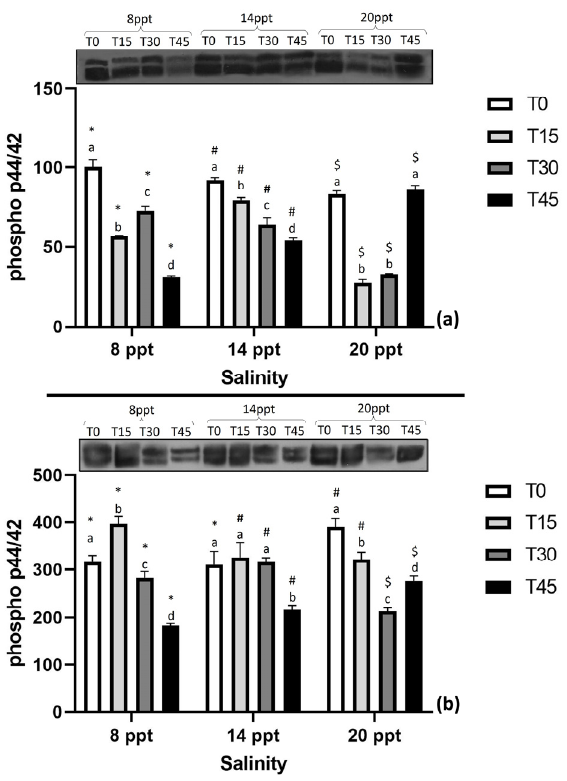
Figure 3. Phosphorylation levels of p44/42 MAPK in the liver ( a ) and gills ( b ) of gilthead sea bream following exposure to a salinity of 8, 14, or 20 ppt for 0, 15, 30, and 45 days. Different bar colors represent the exposure time to the experimental salinities (T0: 0 days, T15: 15 days, T30: 30 days, and T45: 45 days). Data are expressed as mean values of three replicates ± S.D. Different letters depict significant changes in phosphorylated levels of p44/42 MAPK between different exposure times in each salinity, while different symbols (*, #, and $) are used to denote significant differences between the three experimental salinities at the same exposure time.